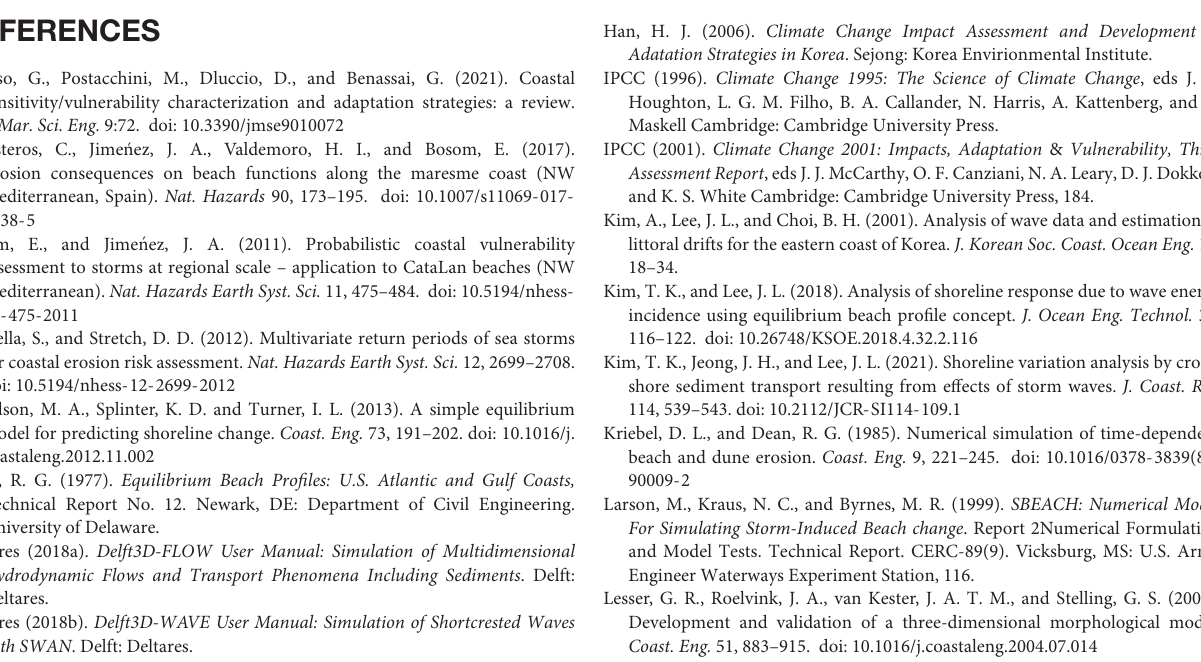
Supplementary Figure 2 | Tide table (A) and wave rose (B) of Maengbang coast. Supplementary Figure 3 | Time series data of significant wave height ( H S ) at Maengbang coast from the NOAA dataset (1979–2018). Supplementary Figure 4 | Time series data of peak wave period ( T p ) at Maengbang coast from the NOAA data (1979–2018). Supplementary Figure 5 | Temporal change of annual mean wave data from 1979 to 2018: (A) annual mean wave height; (B) annual mean wave period; (C) annual mean wave direction. Supplementary Figure 6 | Joint probability of wave height ( H S ) and wave period ( T S ) at Maengbang coast from the NOAA dataset (1979–2018). Supplementary Figure 7 | Dimensionless wave height scenario model for Maengbang Beach. Supplementary Figure 8 | Dimensionless wave period scenario model for Maengbang Beach.